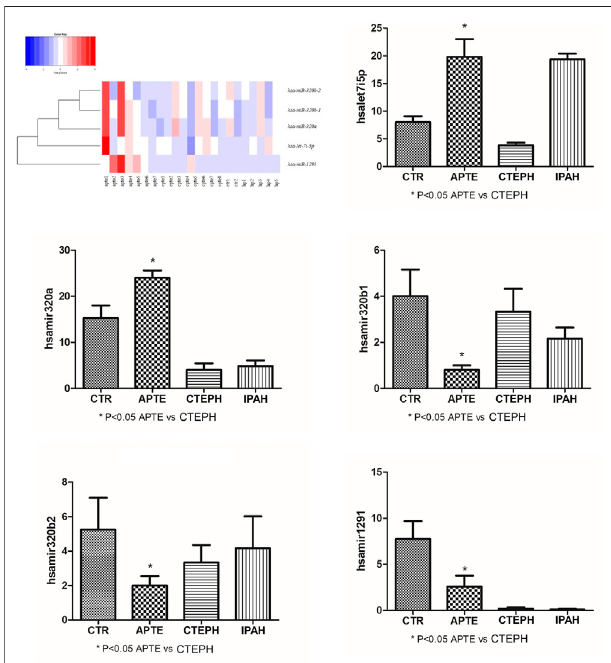
FIGURE 3 | Heatmap and box plots graphs representing the fi ve miRNAs — let-7i-5p , miR-320a , miR-320b-1 , miR-320b-2 , and miR-1291 signi fi cantly associated with the APTE group compared to the CTEPH group after testing adjustment by FDR (Benjamini – Hochberg). Red and blue colorsrepresent increasedand decreasedexpression levels(transformedinto z -scores),respectively,whencomparedwiththeaveragelevelofeachmiRNA. APTE, acute pulmonary thromboembolism; CTEPH, thromboembolic pulmonary hypertension; PAH, idiopathic pulmonary hypertension; and CTR, Controls.